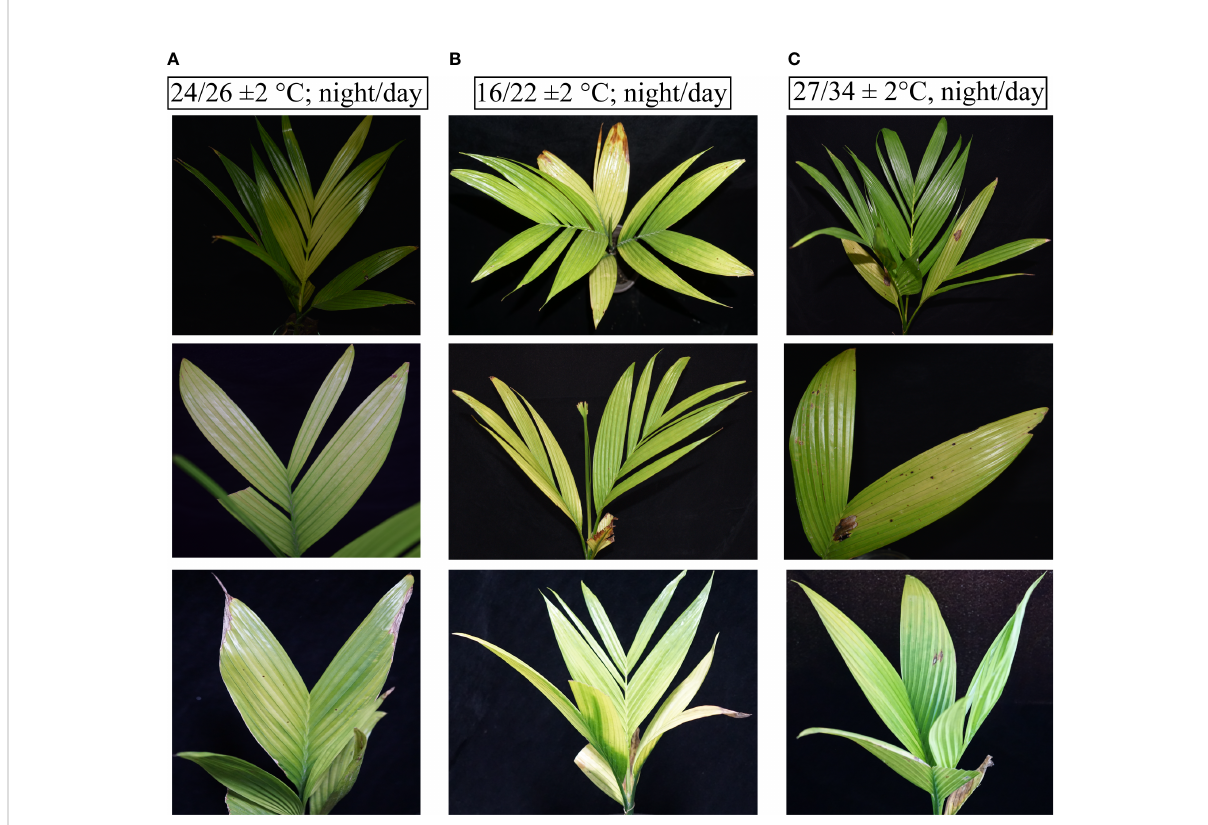
FIGURE 5 Symptoms of YLD recorded under different temperatures. (A) The YLD symptoms emerged at room temperature (24/26°C; night/day). (B) The YLD symptoms emerged at low temperatures (16/22 ± 2°C; night/day, 16L:8D; Light, 5LS; RH, 75%). (C) The YLD symptoms emerged at high temperatures (27/34 ± 2°C, night/day, 16L:8D; Light, 5LS; RH, 75%). Ten seedlings for each speci fi c temperature analysis, n = 10, were kept in an incubator under controlled conditions for 1 month.